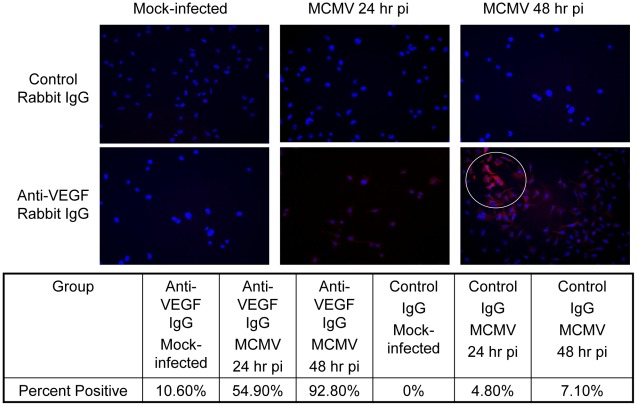
MCMV infection of monolayers of IC-21 mouse macrophages results in VEGF production by virus-infected and bystander uninfected cells.Monolayers of IC-21 mouse macrophages were either mock infected or infected with MCMV (2.5 PFU/cell). At 24 hour postinfection (MCMV 24 hr pi) or 48 hour postinfection (MCMV 48 hr pi), all mock-infected and MCMV-infected cells were harvested, fixed, and reacted with either control rabbit IgG or anti-VEGF rabbit IgG as primary antibody for visualization of VEGF production. All cells were counterstained with DAPI to visualize cell nuclei. VEGF = Red; DAPI = Blue (Magnification = 200×) White circle emphasizes focus of cells at 48 hr postinfection undergoing cytopathology and plaque formation. Quantification of cells exhibiting positive staining for VEGF was accomplished by using mean values of the number of cells showing obvious red cytoplasmic staining within five random microscopic fields of view.